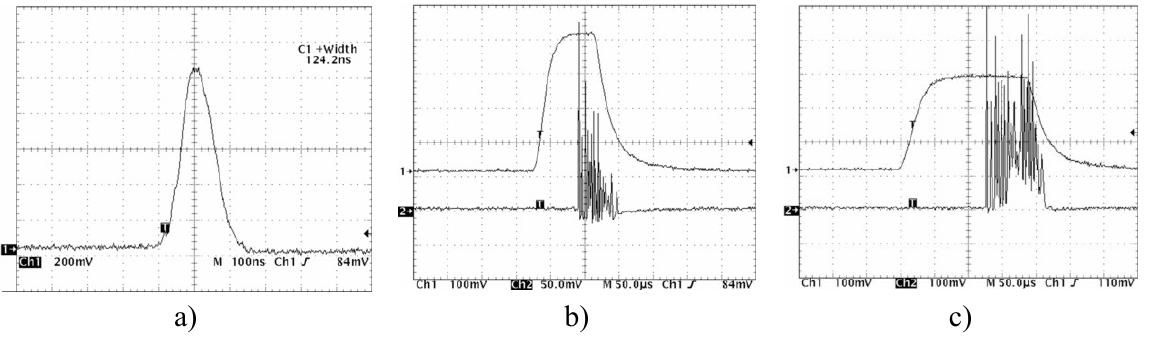
Figure 15. Time dependence of the Er:YAG laser pulses for different generation regimes: a) Q-switching – 125 ns with output energy 11 mJ; b) short free running - 60 μ s burst of about ten pulses of 1 μ s duration with output energy 10 mJ; c) free running – 120 μ s burst of dozens pulses of 1 μ s duration with output energy 21 mJ.